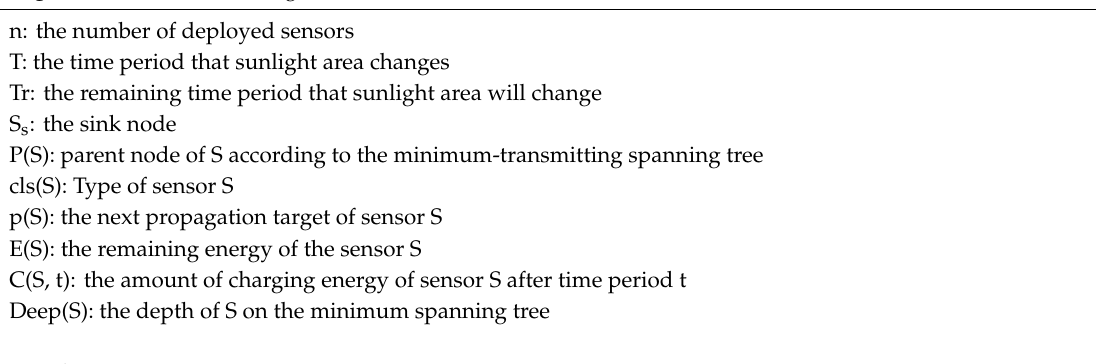
Algorithm 1. The CMRP